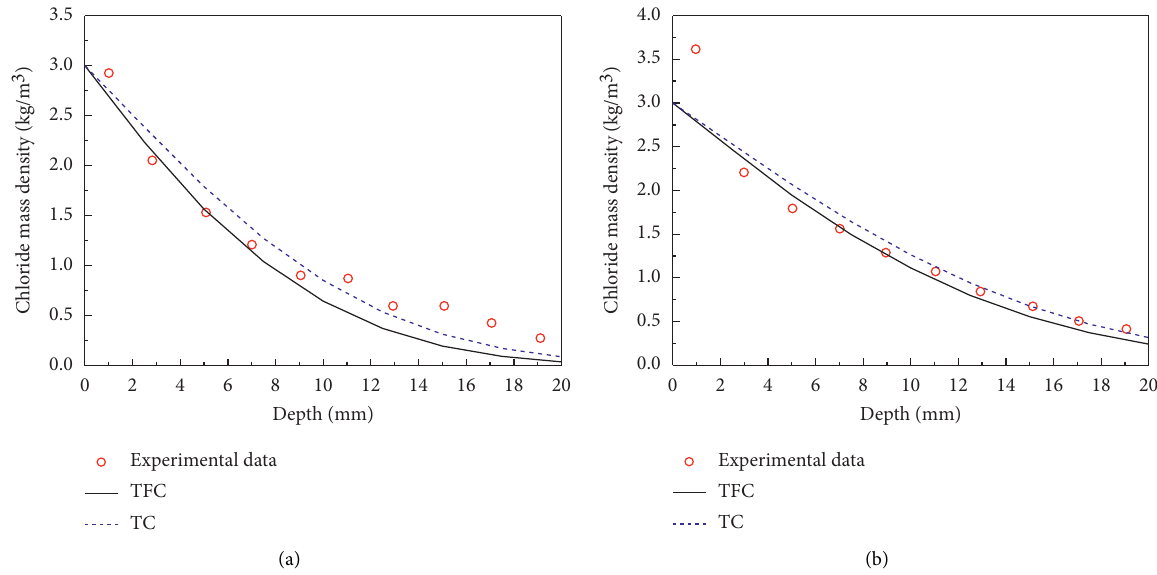
Figure 7: Experimental and simulated distribution of mass densities of chloride. (a) t � 90 days and (b) t � 180 days.